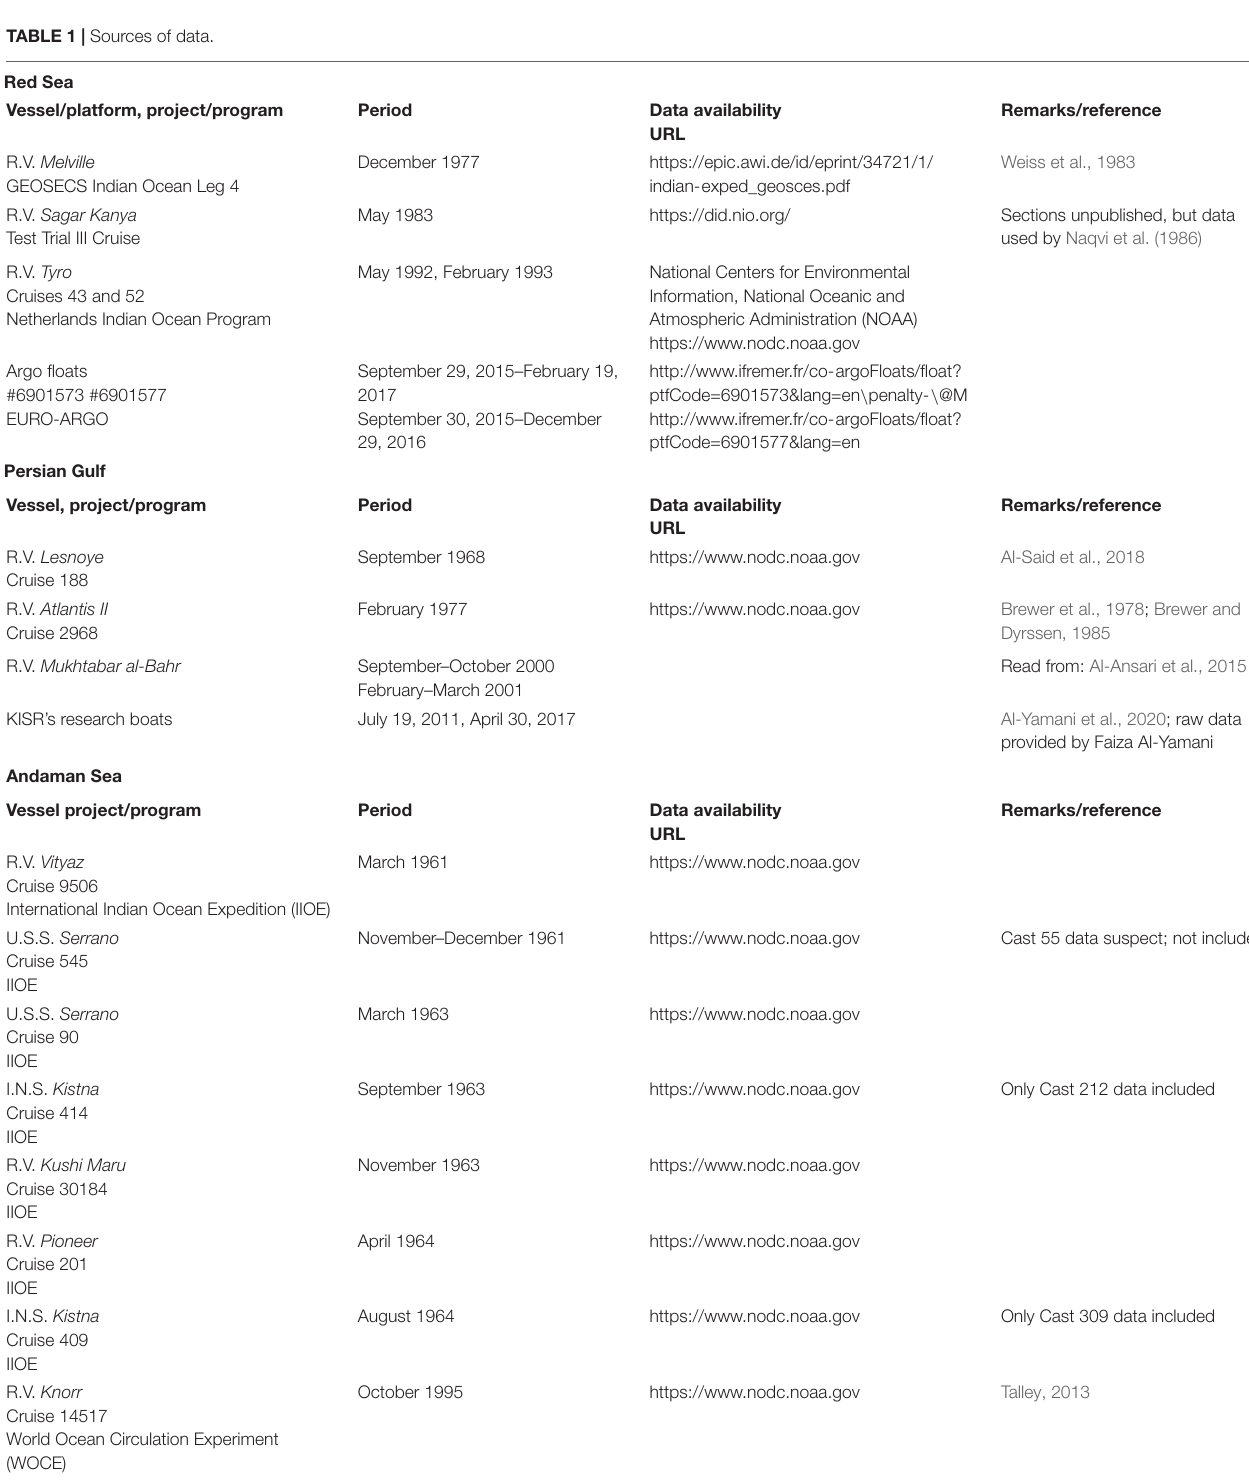
TABLE 1 | Sources of data. Red